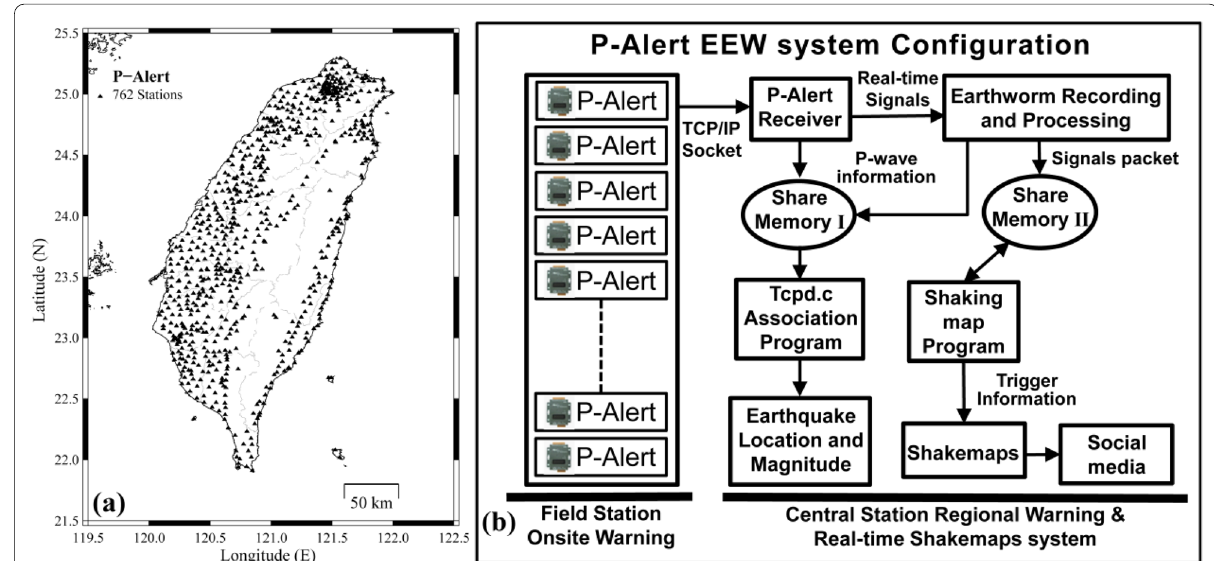
Fig. 3 a Station distribution and b configuration of the P‑Alert EEW